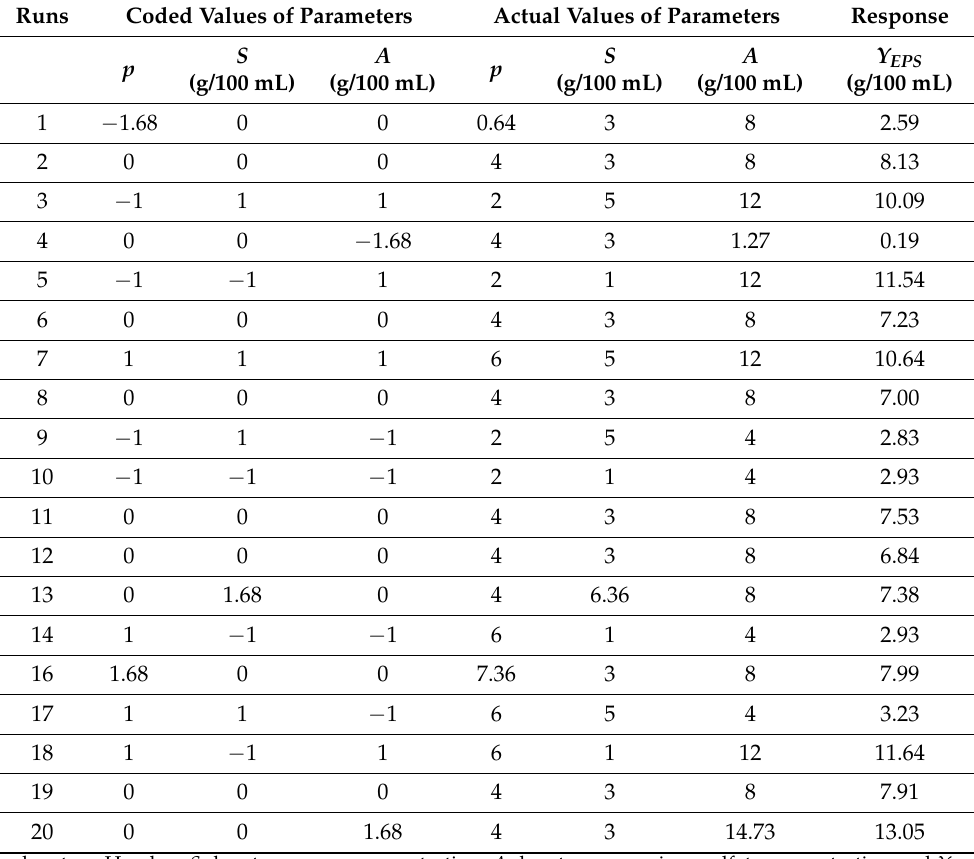
Table 2. The yield of crude exopolysaccharides (EPSs) generated at the different process conditions. Runs Coded Values of Parameters Actual Values of Parameters Response S p (g/100